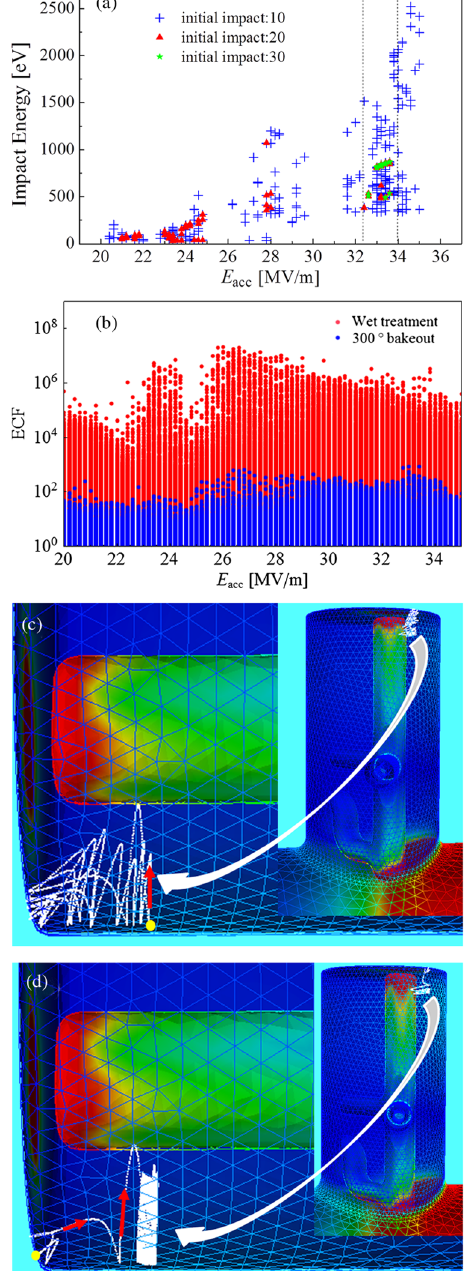
FIG. 6. Characteristics of zone 2 MP: (a) electron impact energy; (b) ECF after impacting for 20 rf periods; (c) typical electron trajectories of quasiresonant MP for gradients in the range of 21 – 30 MV = m. The initial emission electron is from the yellow dot position moving forward with the red arrow direction. The emission electrons will ultimately slip out of the resonant phase after some number of impacts and ultimately get lost. (d) Typical electron trajectories of “ hard ” MP for gradients in the range of 32 – 35 MV = m. The initial emission electron is from the yellow dot position moving forward with the direction shown in the figure. Finally, the emission electrons form a stale